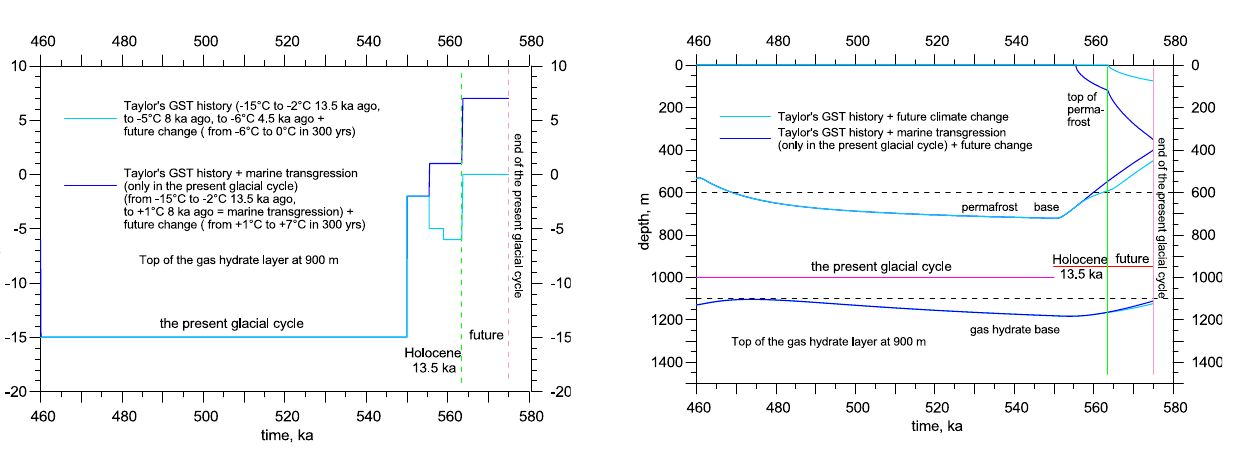
Fig. 11. The onshore and offshore (the Holocene marine transgression) GST models of the present glacial cycle and the future warming in its end. The Holocene starts at time 550 ka of the simulations and the present time is 563.5 ka.